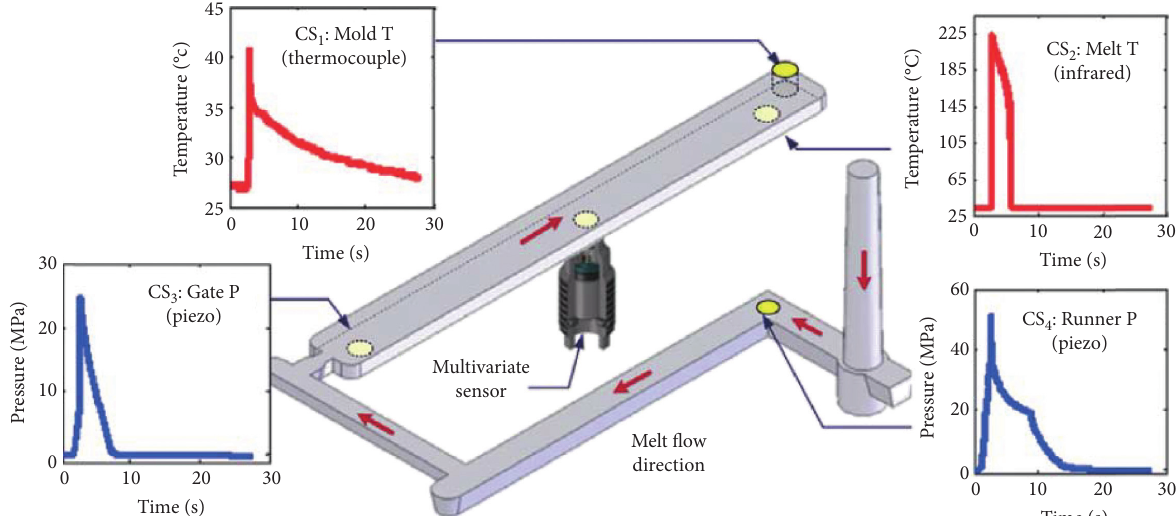
Figure 3: Process instrumentation using commercial sensors (CS) for pressure (P) and temperature (T), as well as a developed multivariate sensor (MVS) within an injection mold cavity [30].